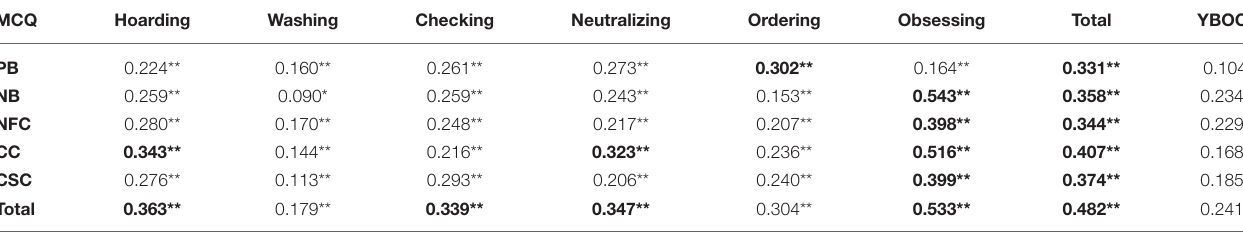
TABLE 3 | Correlation between MCQ subdimensions, OCI-R-K subscales, and Y-BOCS scores.